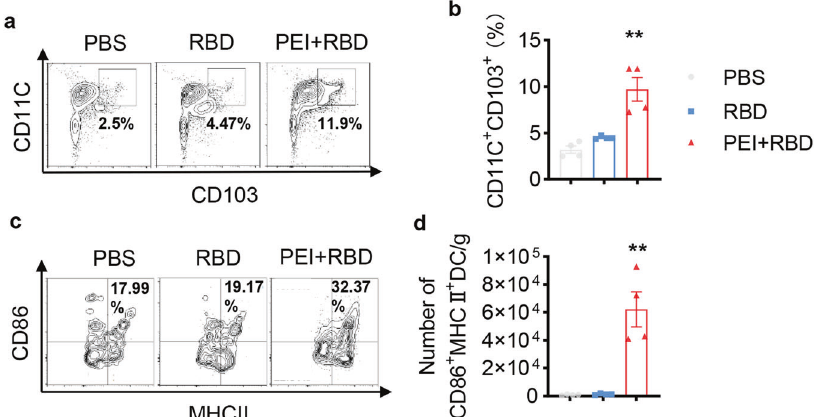
Fig. 5 Intranasal immunization with adjuvanted RBD vaccine induces the formation and maturation of CD103 + DCs in the lungs. C57BL/6 mice were intranasally immunized with PBS, RBD, and PEI-adjuvanted RBD vaccine on days 0, 7, and 21. On day 28, immunized mice were sacri fi ced and lung tissues were harvested for the detection of CD103 + DCs in lung tissues with FCM. Representative FCM plots ( a ) and quanti fi cation ( b ) of CD103 + DCs in the lungs. c Representative FCM plots of CD86 and MHC II expression on lung CD103 + DCs. d Quanti fi cation of lung CD86 + MHC-II + CD103 + DCs. All the data were presented as mean ± SEM. n = 4. P values were compared to PBS group (** P < 0.01) Signal Transduction and Targeted Therapy (2022)